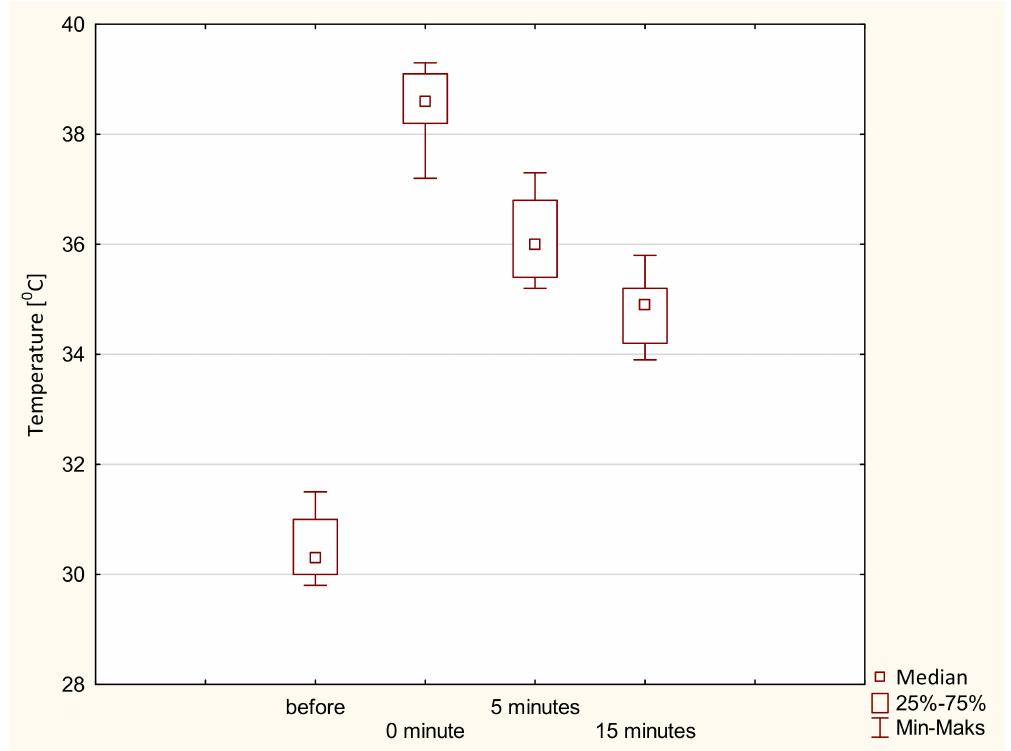
Figure 6. Changes in tissue temperature during the conducted observations after the use of a resistive